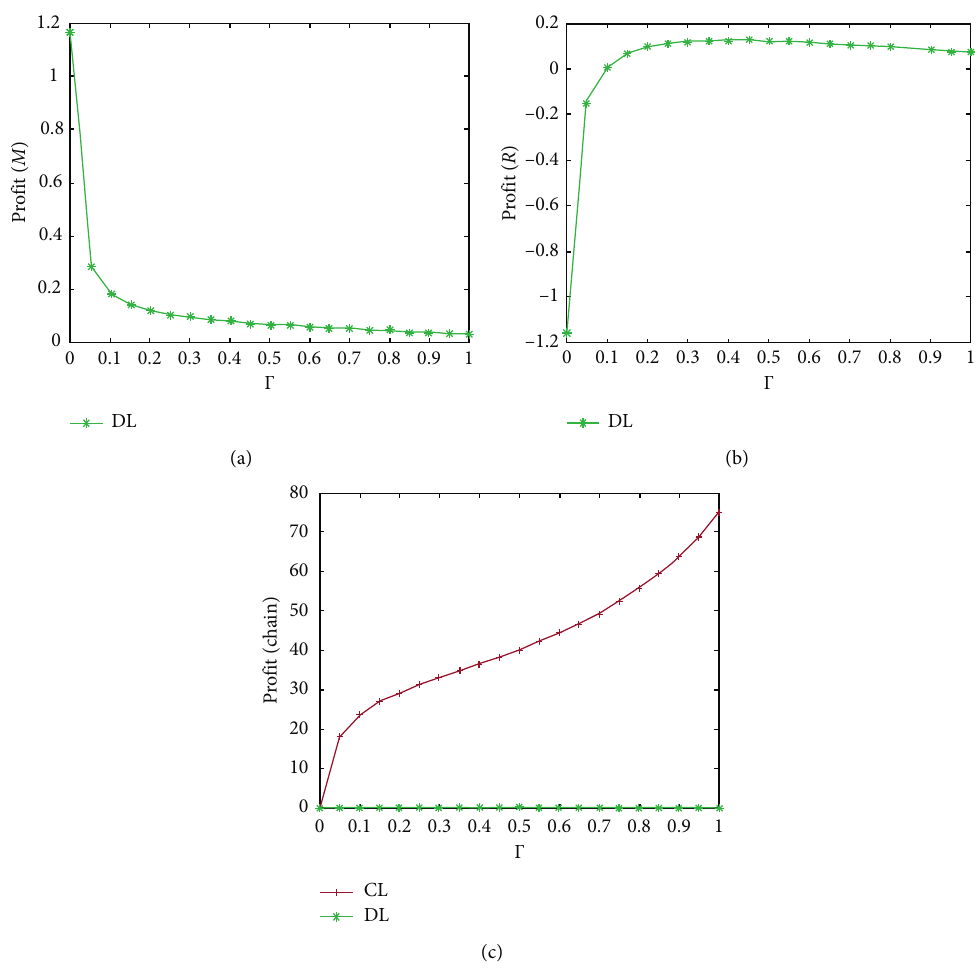
Figure 4: Effort of consumer heterogeneity on supply chain profit. Table 3: Profit comparison of